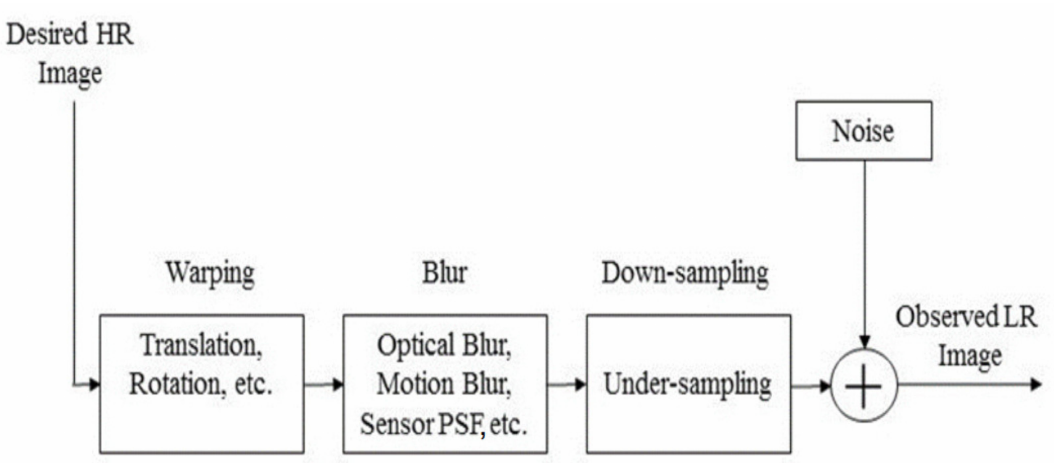
Figure 5. Image degradation step.